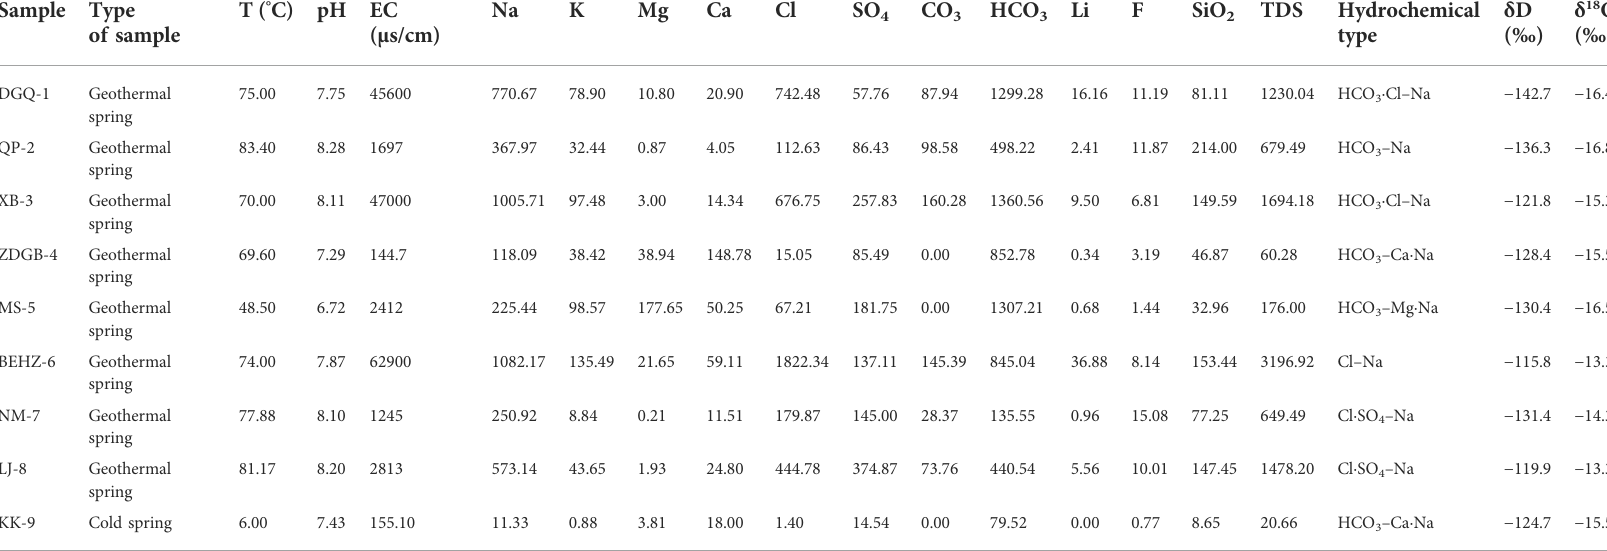
Note: δ D and δ 18 O were expressed in ‰ vs. V-SMOW,